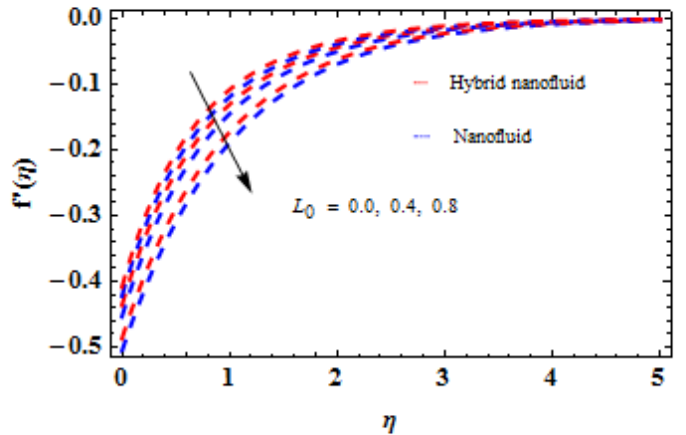
Figure 15. Influence of 𝐿 0 via 𝑓′(𝜂).